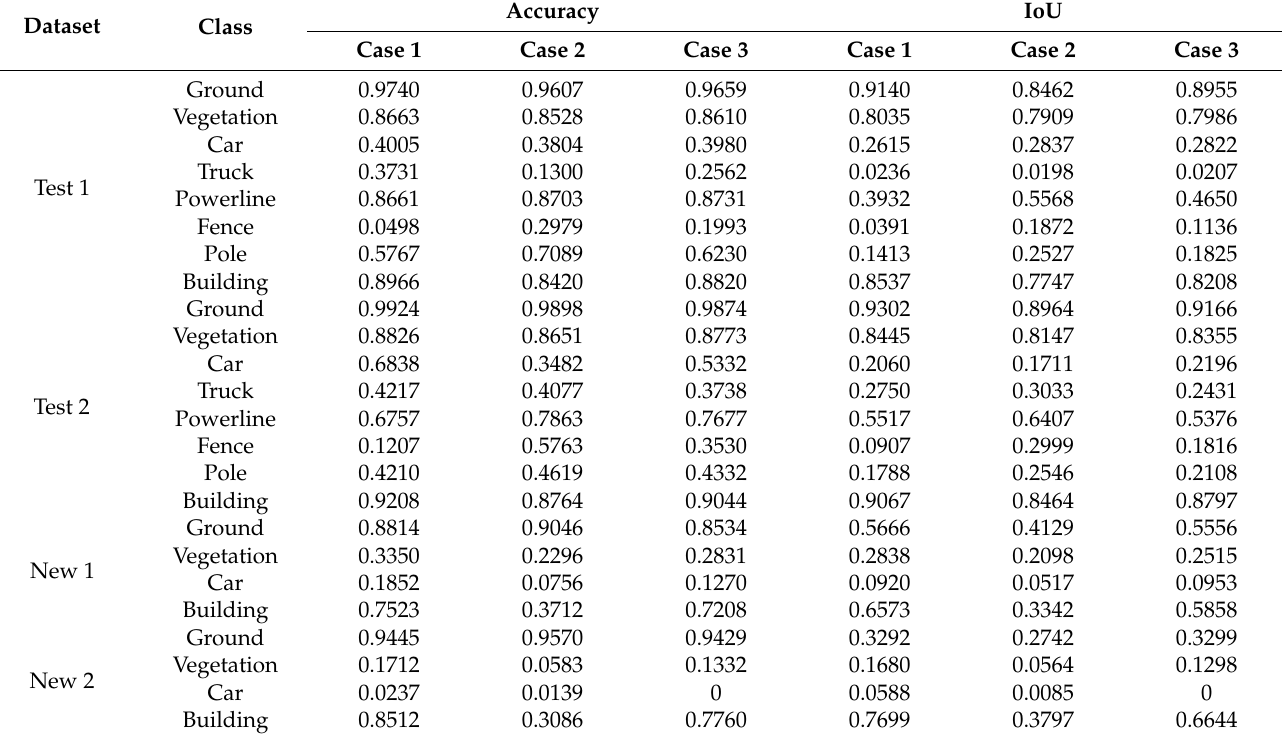
Table 4. Classification accuracy of test and new data.